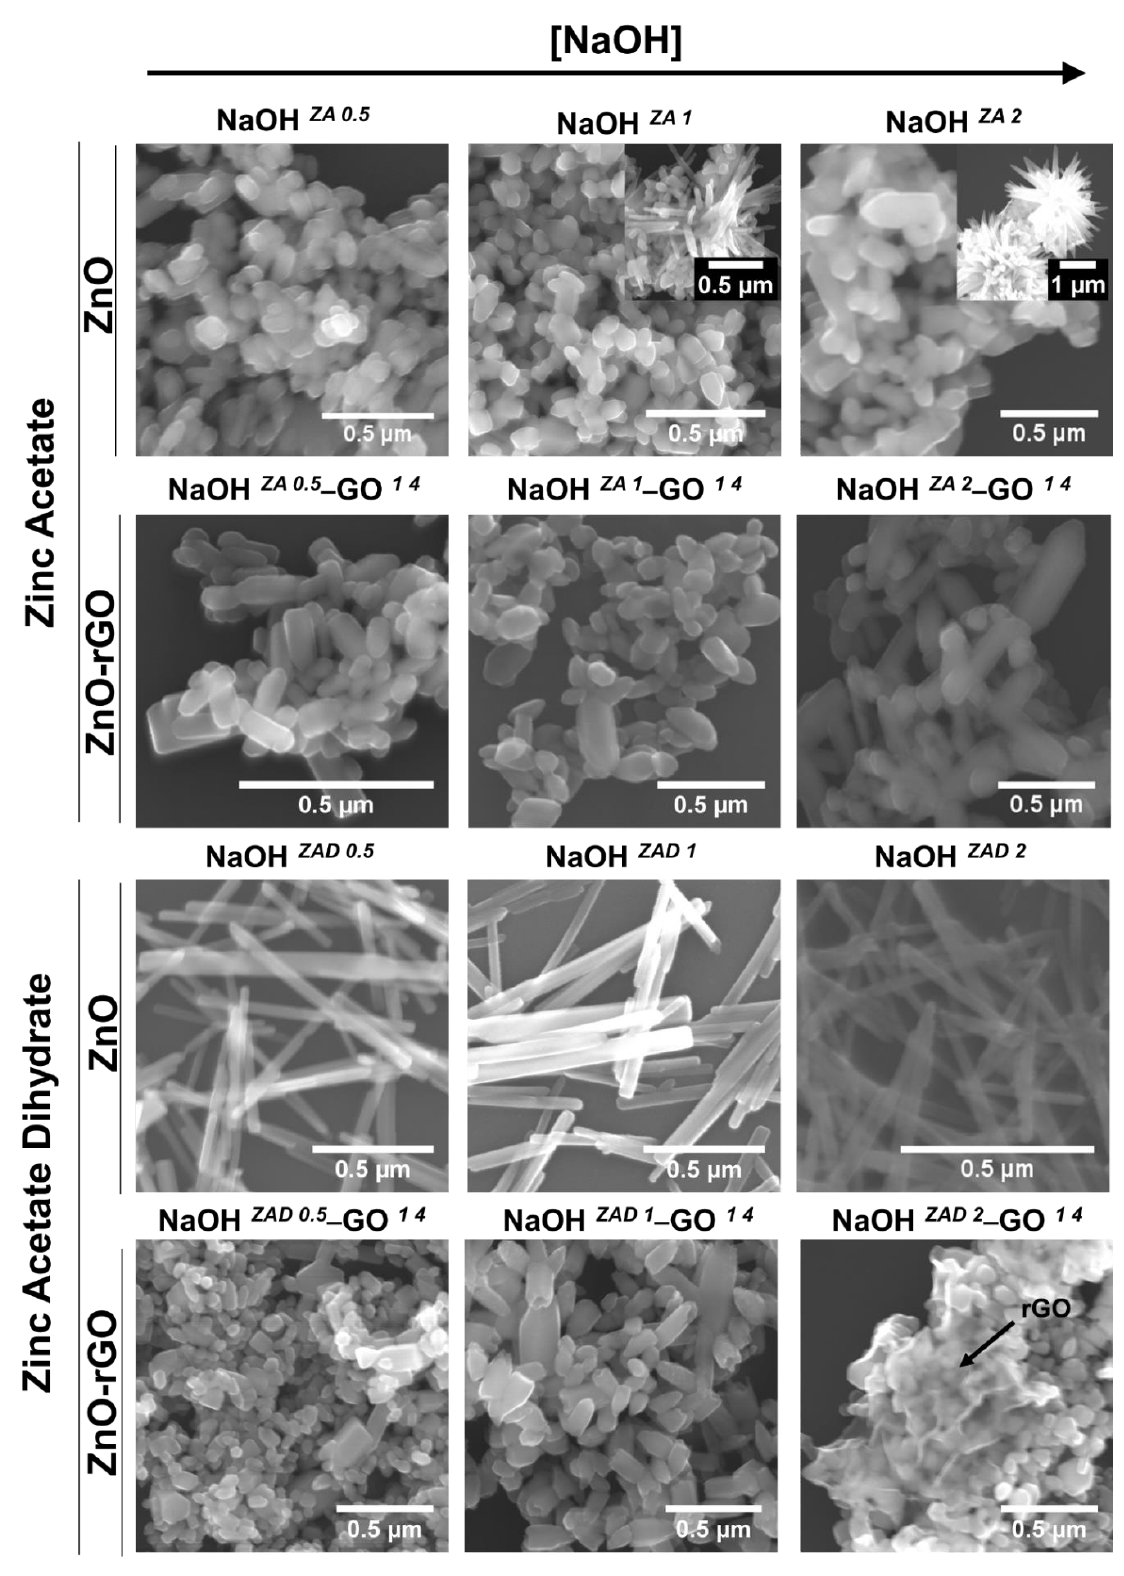
Figure 2. SEM micrographs of ZnO and ZnO–rGO composites obtained by solvothermal synthesis using zinc acetate anhydride and dehydrated and NaOH concentrations of 0.5, 1.0 and 2.0 M. The inset images at NaOH ZA 1 and NaOH ZA 2 samples represent additional morphologies of ZnO particles with anisotropic growth directions.